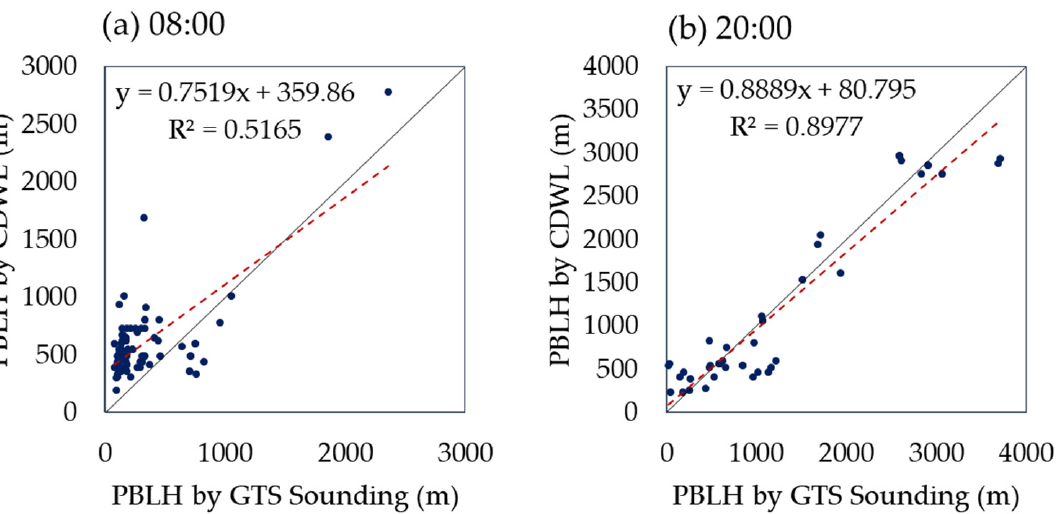
Figure 8. Comparison of CDWL and GTS sounding PBLH inversions at ( a ) 08:00 BJT and ( b ) 20:00 BJT in the effective altitude range. The regression line (red line) and reference line y = x (black line) are also shown.